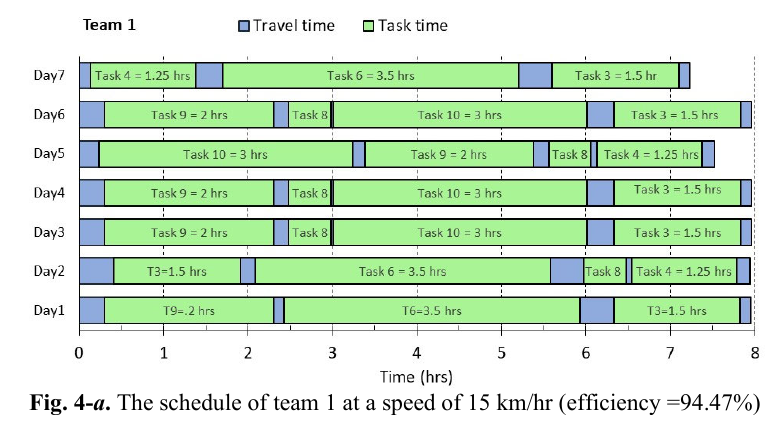
Fig. 4- a . The schedule of team 1 at a speed of 15 km/hr (efficiency =94.47%)